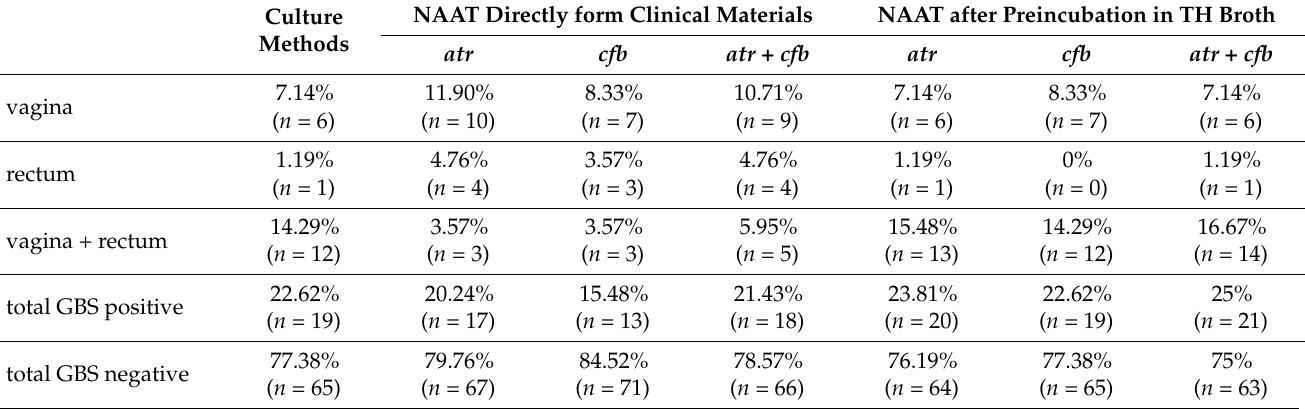
Table 3. Carriage of GBS established by culture with preincubation in TH broth medium and NAAT- based methods (conventional PCR with the use of atr primers and real-time PCR with the use of cfb